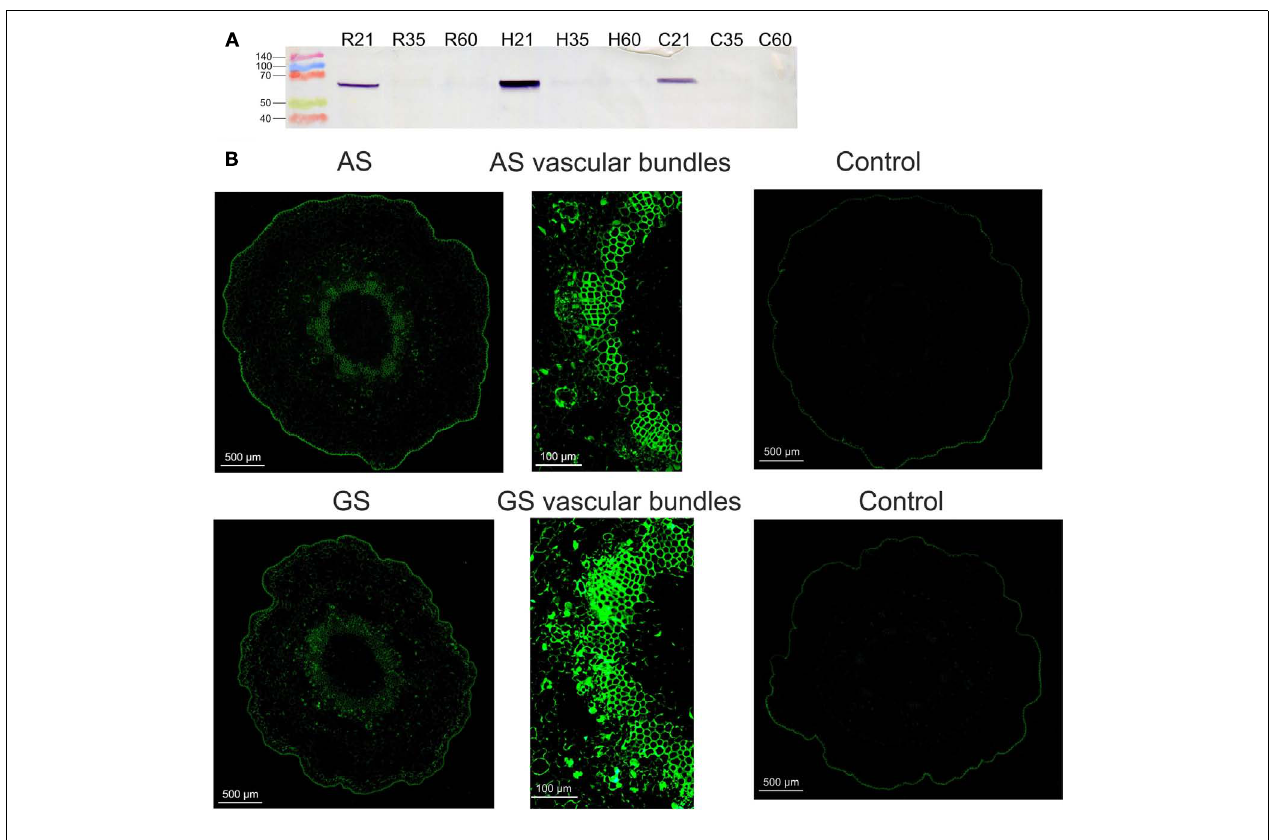
FIGUREA1 | Immunodetection ofAS protein in maritime pine seedlings. (A) Western blot analysis of protein extracts from roots (R21, R35, and R60), hypocotyls (H21, H35, and H60), and cotyledons (C21, C35, and C60).The numbers indicate days after inhibition.